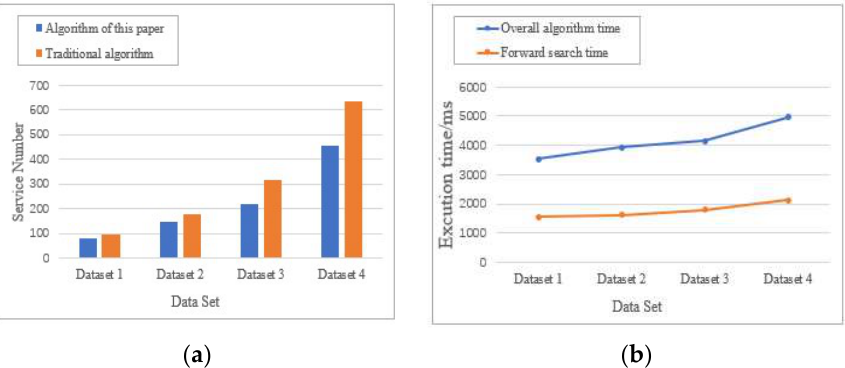
Figure 6. Evaluation of constraint-aware GraphPlan algorithm. ( a ) The number of services in the planning graph; ( b ) The execution time of the overall algorithm and the forward search algorithm.